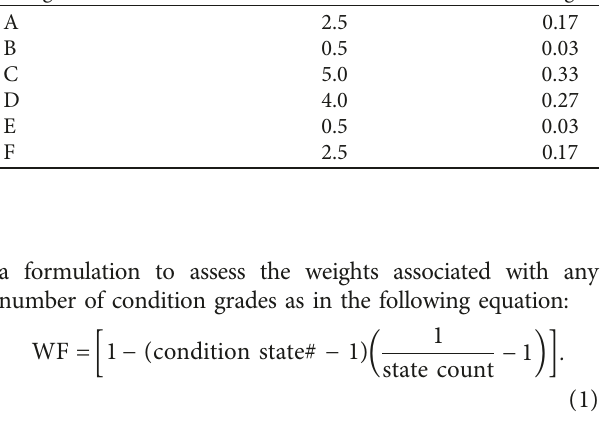
Table 4: Weights of the bridge deck subelements. Bridge